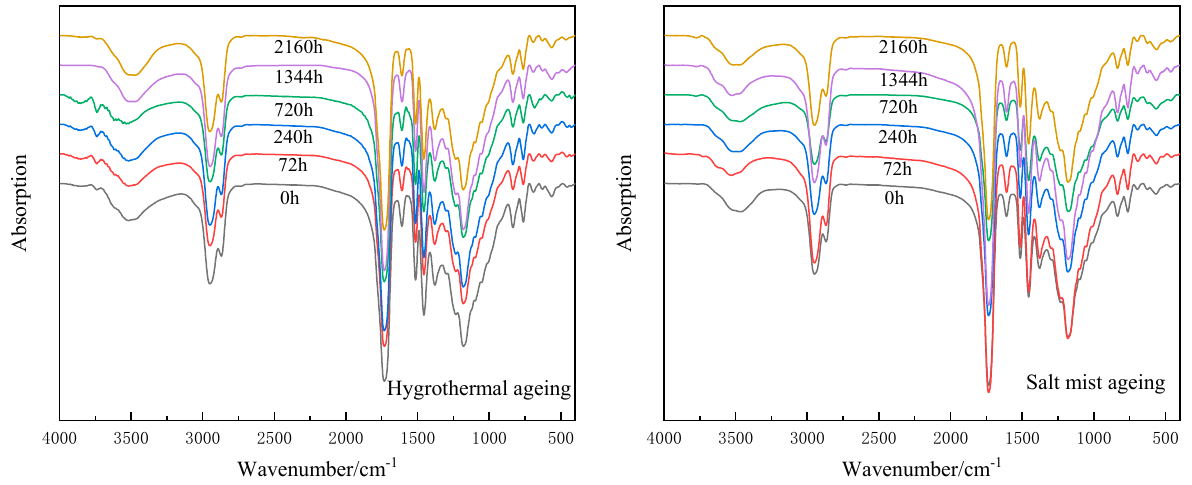
Figure 9. Infrared spectra of the epoxy resin casting sheets after hygrothermal ageing ( left ) and salt mist ageing ( right ).